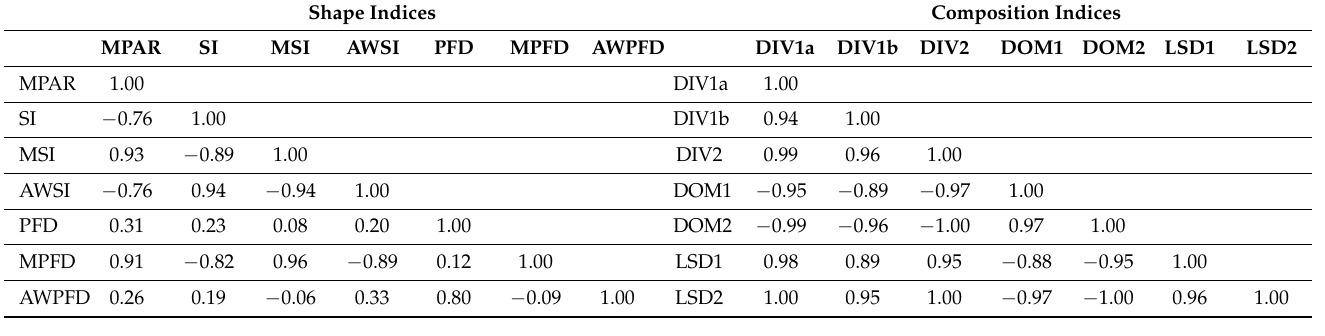
Table 3. Correlation coefficients matrixes for shape indices (MPAR: Mean Perimeter area ratio; SI: Shape index; MSI: Mean Shape index; AWSI: Area weighted mean shape index; PFD: Patch fractal dimension; MPFD: Mean patch fractal dimension; and AWPFD: Area weighted mean patch fractal dimension) and for composition indices (DIV1a: Diversity_1a /tot; DIV1b: Diversity_1b /land-